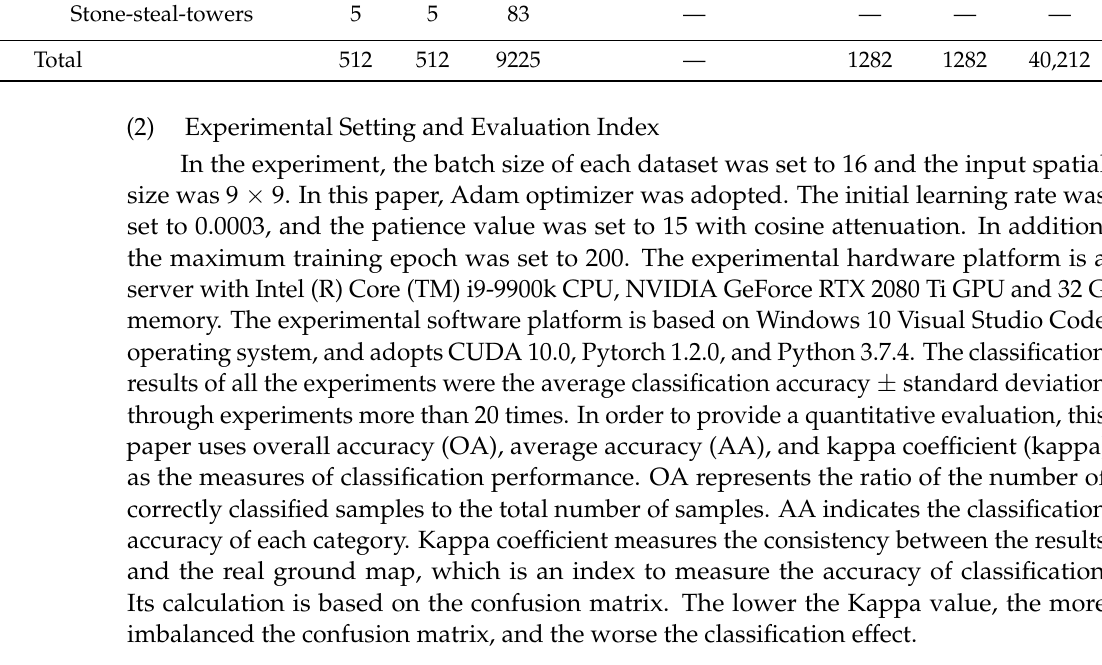
Table 2. Land cover category and number of samples for training, validation, and testing of SV and